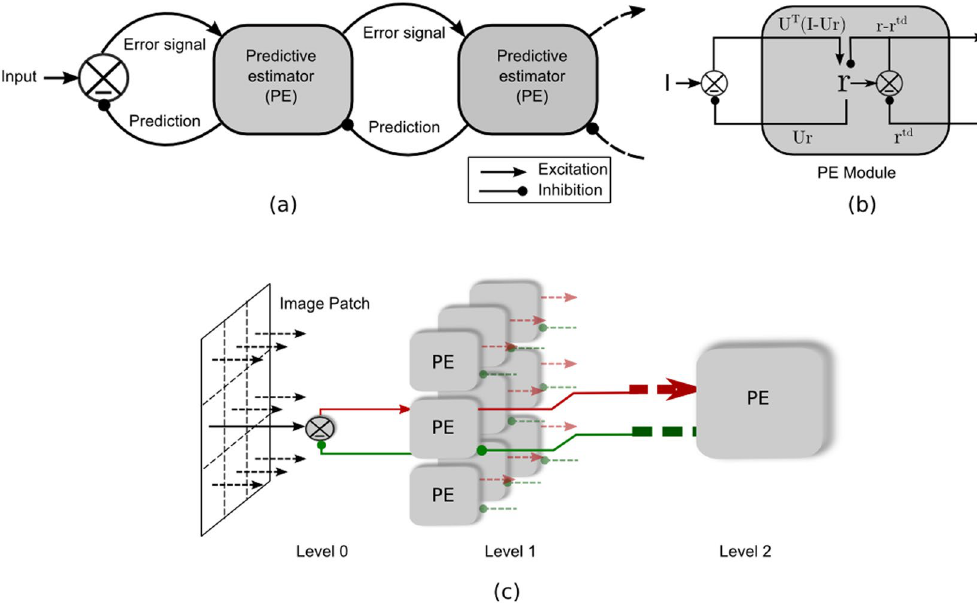
Figure 9. Hierarchical predictive coding (HPC) 20 . ( a ) The general mechanism of Hierarchical Predictive Coding is shown schematically. ( b ) The general computational architecture of a predictive estimator (PE) module is presented. ( c ) Details of a three level HPC model network is shown; where level 2 module sends a feedback signal to all 9 level 1 modules and in response, receives back the error signal from all of